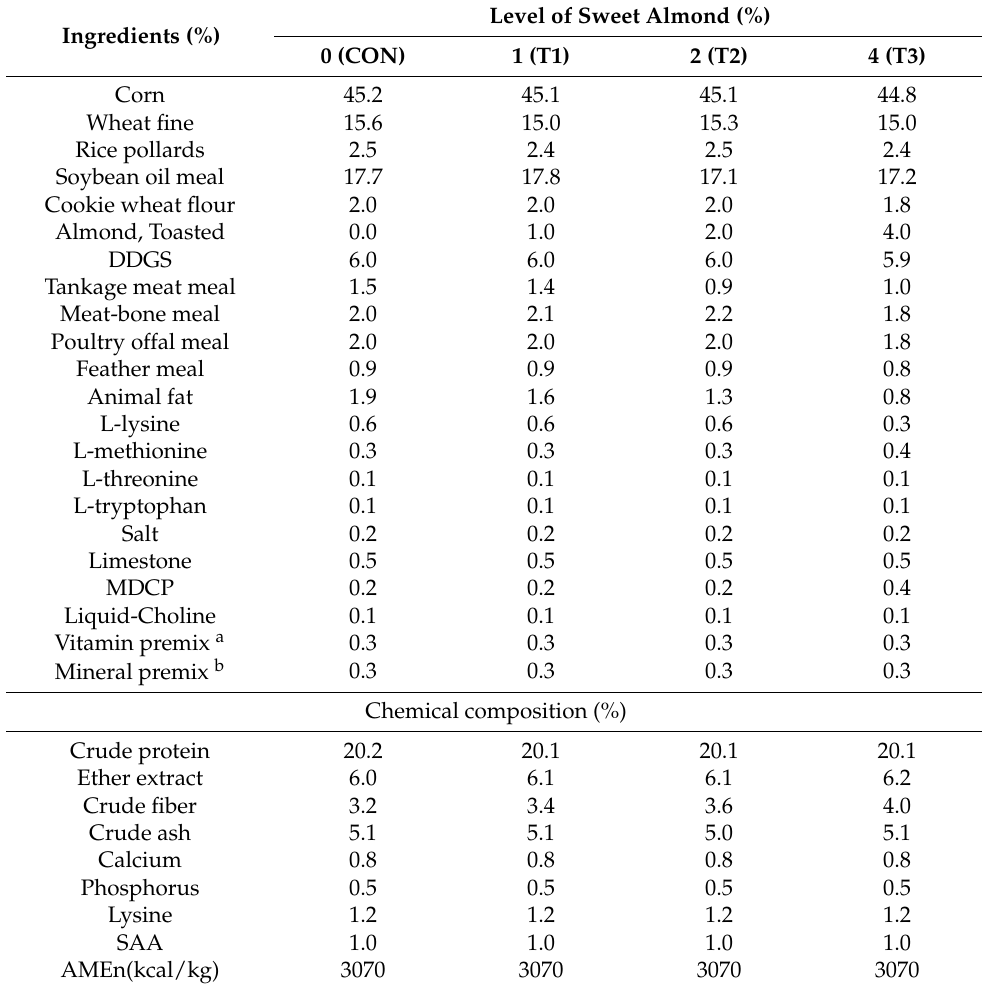
Table 4. Ingredient composition of experimental diets (phase 3/day 15–21).